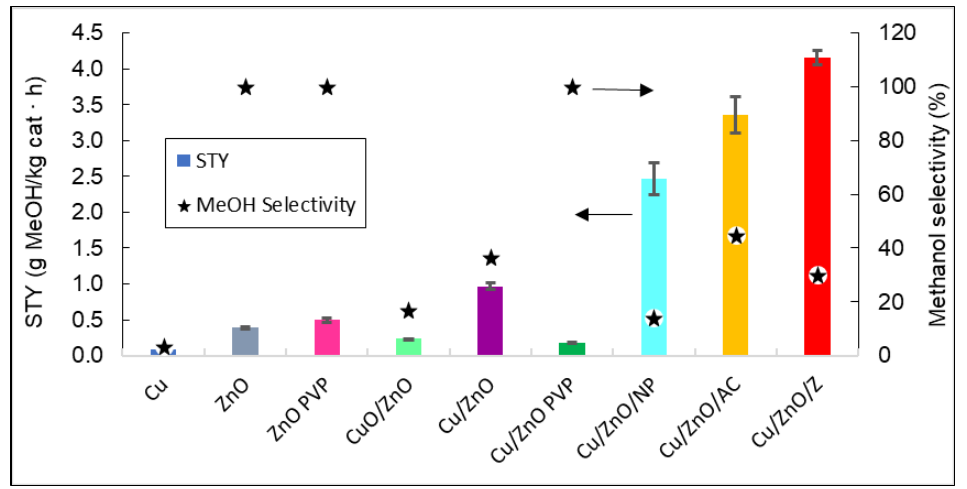
Figure 10. Representation of the STY and the methanol selectivity of all catalysts. The arrows indicate that methanol selectivity values can be read in the right vertical axis, and STY in the left vertical axis.